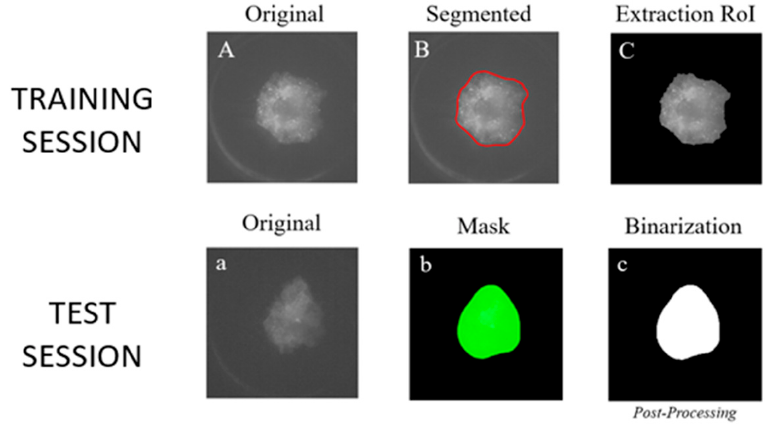
Figure 4. Extraction of the region of interest (RoI) during the training session (( A ) = original image, ( B ) = segmentation of the raw image and ( C ) = extraction of RoI from the segmented image) and determination of the binarized image ( c ), starting from the mask process ( b ) applied on the original image ( a ). The binarized image is obtained during the test session, starting from the outputs of the training session [30].